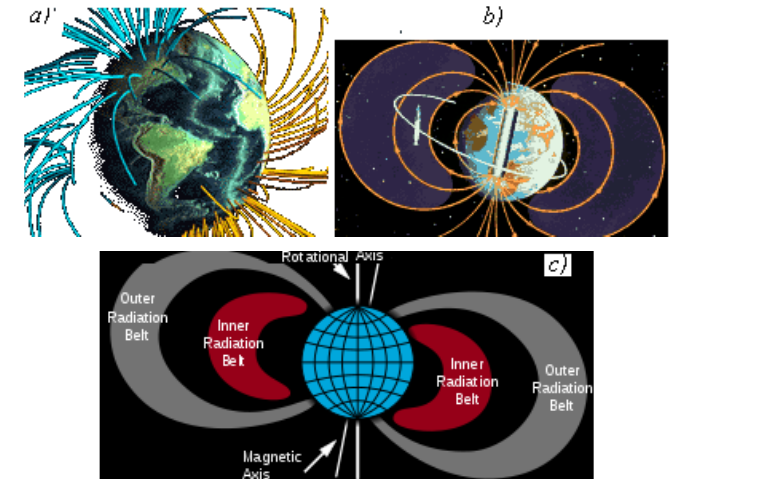
Figure 2 – Earth's magnetic field: a) line of the Earth's field, b) line of the magnetic field with respect to the rotation, c) belts of Van Allen radiation rings, red-inner, gray-outer radiation belt (Bjelić,